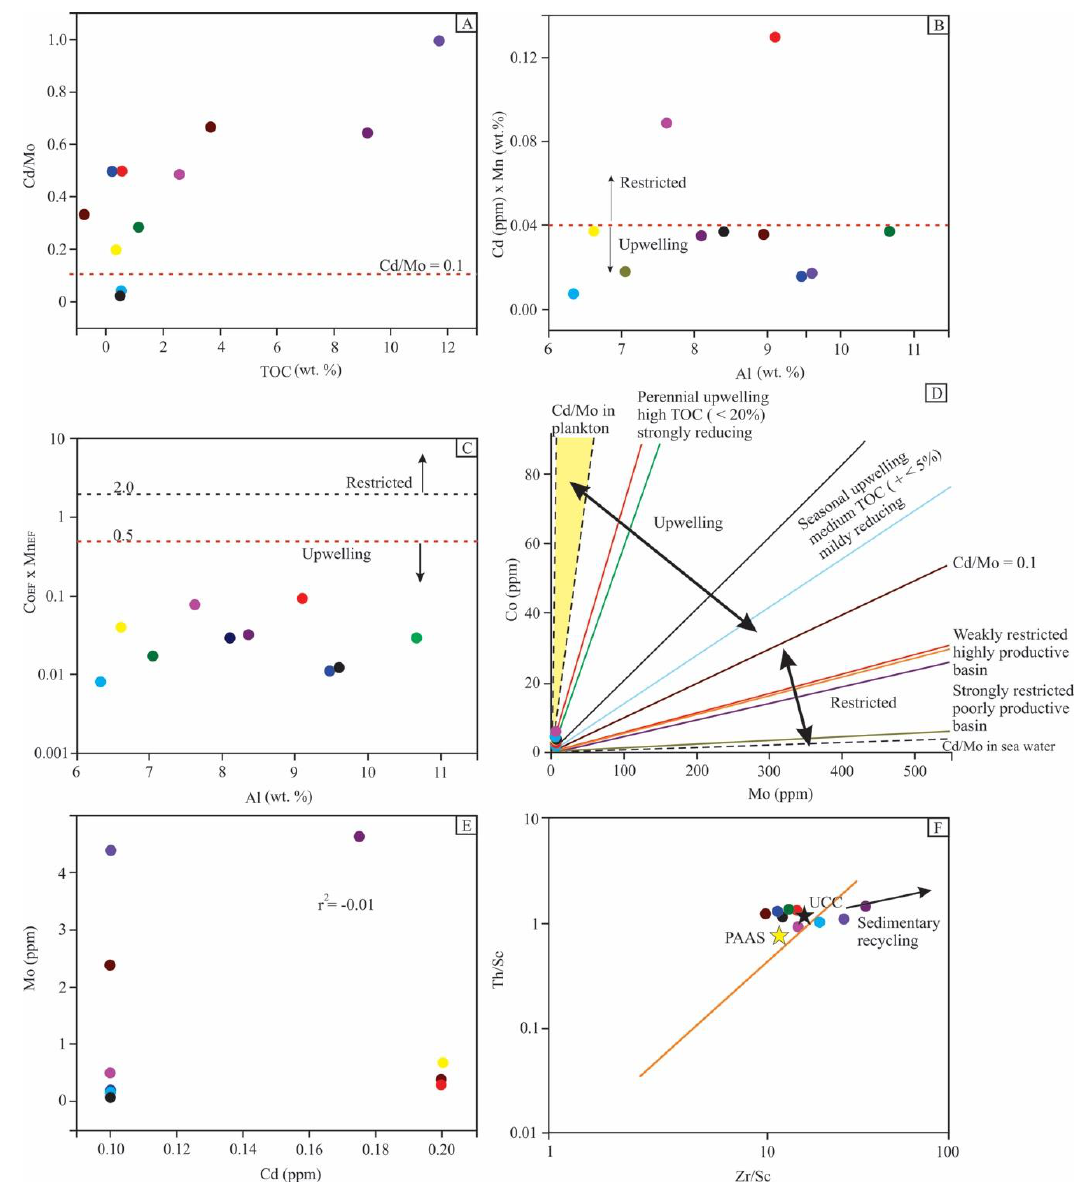
Figure 10. ( A ) plot of TOC (wt.%) content vs. Cd/Mo; ( B ) Al (wt.%) vs. Co (ppm) × Mo(wt.%); ( C ) Al (wt.%) vs. Co EF × Mn EF ; ( D ) Mo (ppm) vs. Cd (ppm) plot showing the characteristic of a restricted setting (inferred conditions based on modern settings, after Sweere et al. [13]); ( E ) Cross-plot of Cd